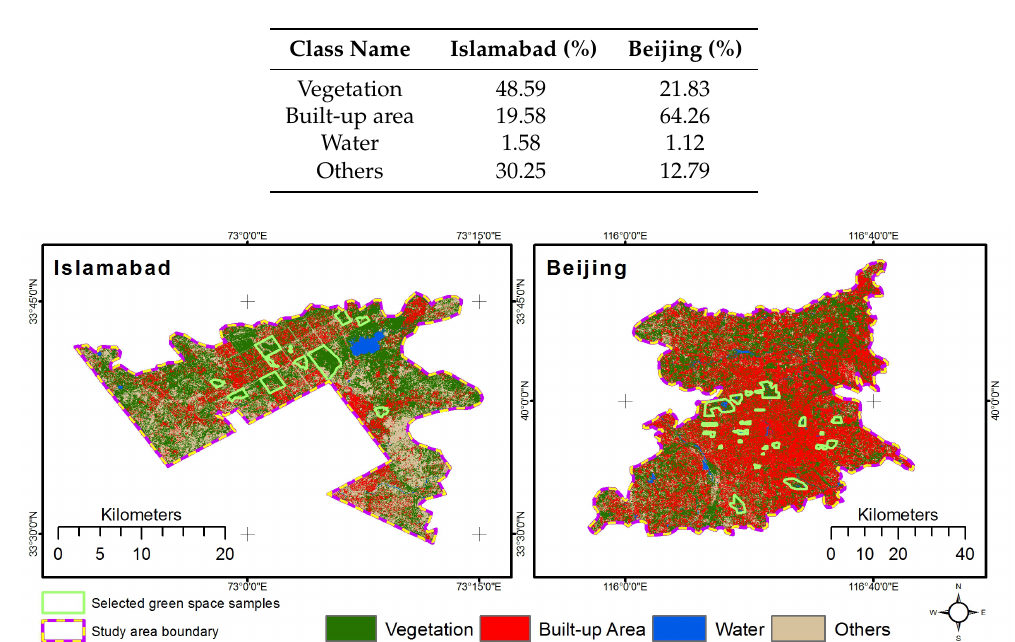
Figure 4. Land cover map of the study area.